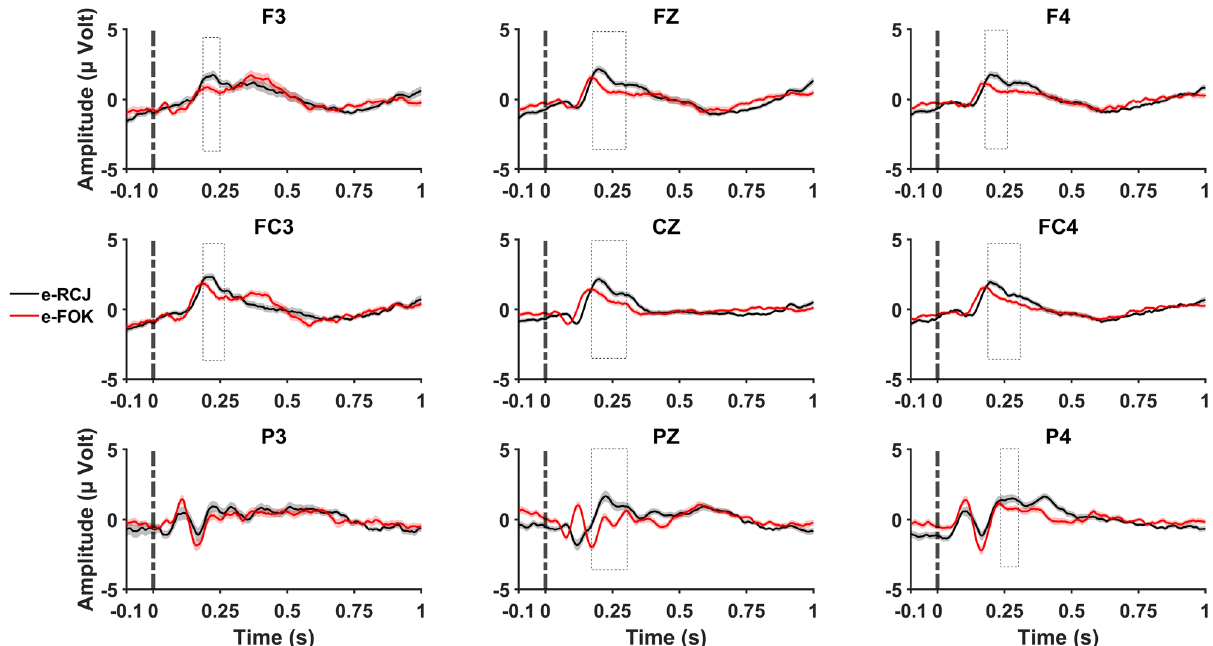
Figure 4. Stimulus-locked ERP grand average with standard errors during the episodic memory task for RCJ (black line) and FOK (red line) at F3, Fz, F4, FC3, Cz, FC4, P3, Pz, and P4 electrode sites Stimulation applied at “0.0 ms” time point (stimulus onset). Cluster-based permutation tests were run within 50–900 ms, and dashed boxes indicate latencies that were found to exhibit significant